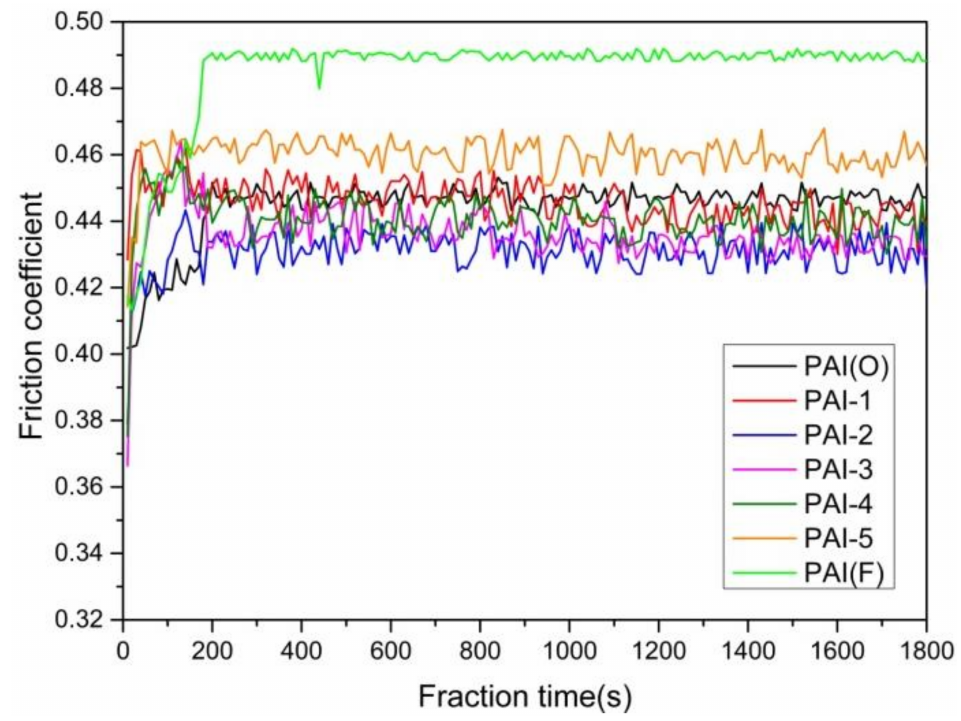
Figure 5. Friction coefficient-time curve of synthetic PAI materials. Table 5. Test and characterization of friction coefficient and wear loss of synthetic PAI